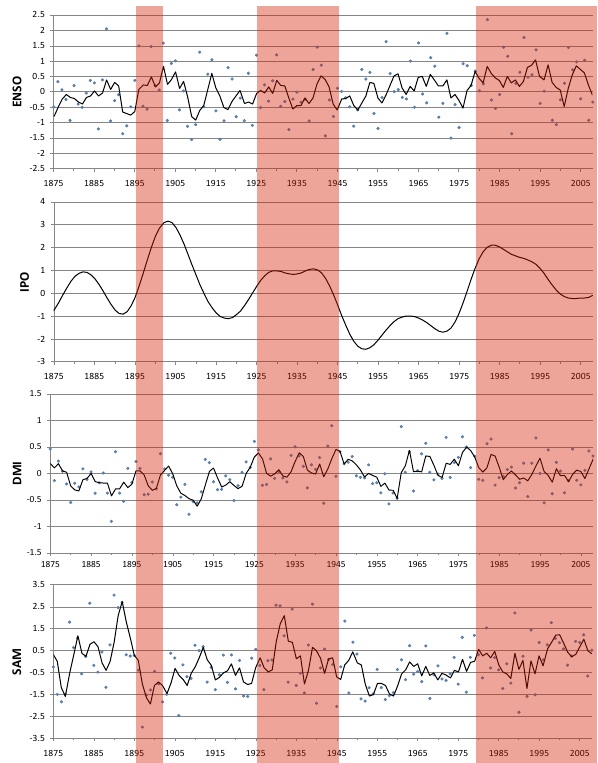
Figure 6. Historical time series of ENSO, IPO, DMI and SAM. Dots represent the mean “annual” value for each index, solid line is the 3year moving average, red shaded regions indicate the common dry periods across the Southern